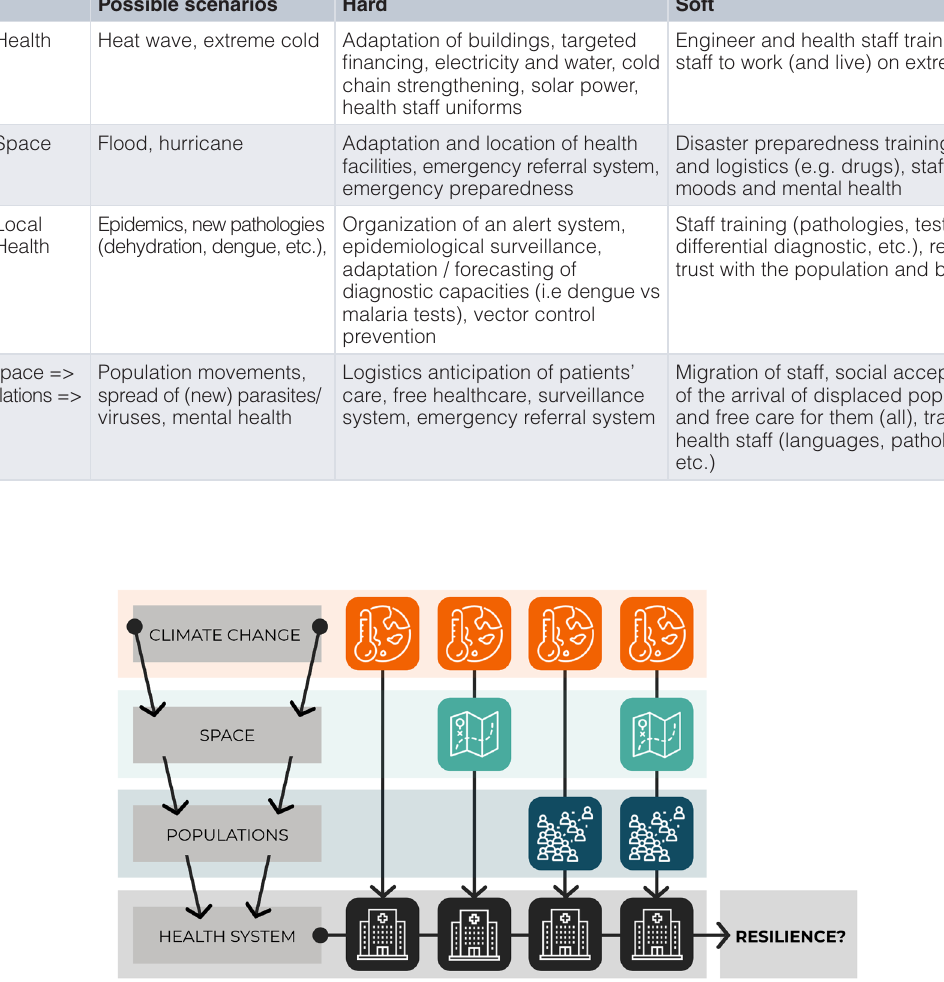
Figure 1. Health systems resilience in the climate change